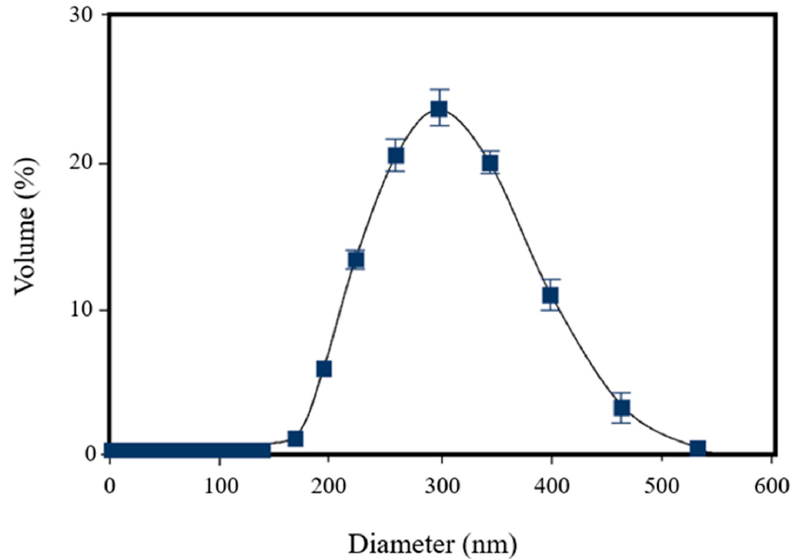
Figure 5. Dynamic light scattering analysis of [ 223 Ra]RaCl 2 co-loaded with [ 198 Au]AuNPs, showing a mean size of 296 nm and a PDI of 0.201 (±0.096).